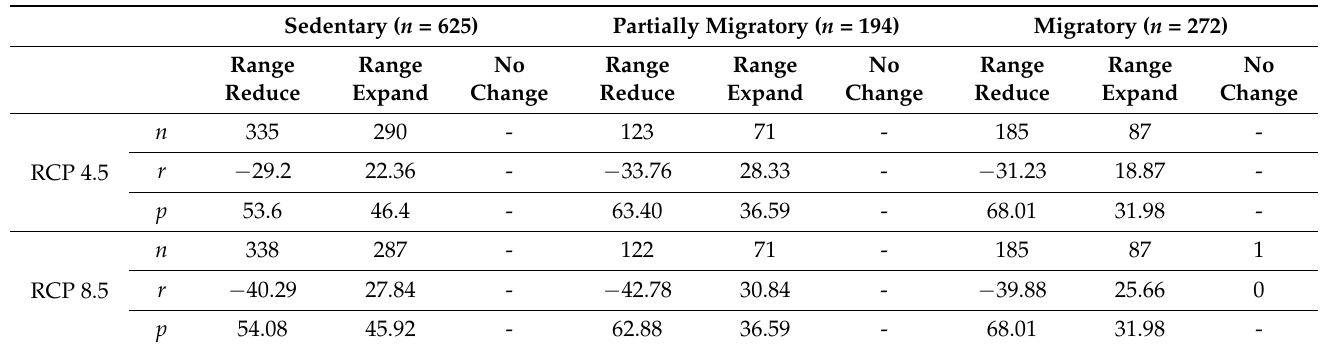
Table 3. Species range changes by the year 2070—comparison for resident and migratory birds in India under the RCP 4.5 or RCP 8.5 scenarios ( n = no. of species, r = % range change, p = % species). Sedentary ( n = 625) Partially Migratory ( n = 194) Migratory ( n = 272) Range Range Range Range No Range Range Reduce Expand Change Reduce